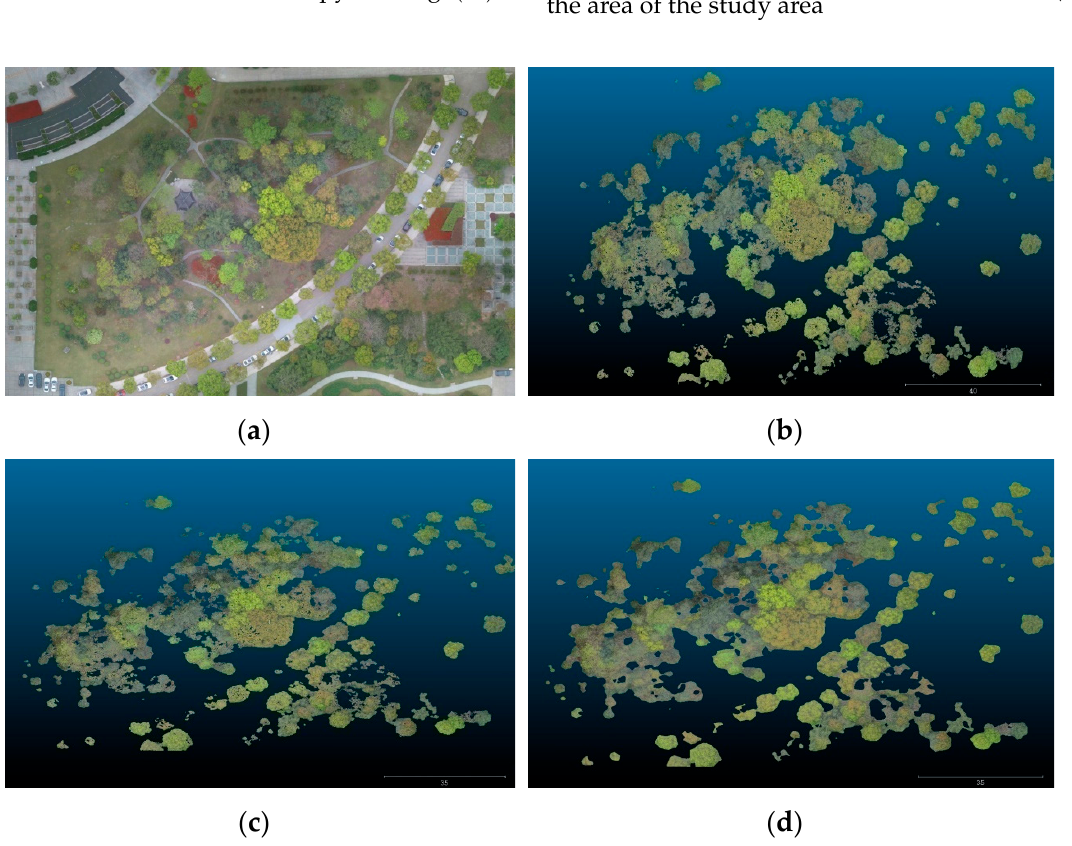
Figure 5. ( a ) The orthophoto map of the study area on 4 April 2019, generated by Agisoft Photoscan, ( b ) 3D point cloud model on 4 April 2019 after extraction by ExG index and separation from near-ground points, ( c ) point cloud model of the canopy in XY plane projected from 3D space, and ( d ) point cloud model of the canopy after surface reconstruction.